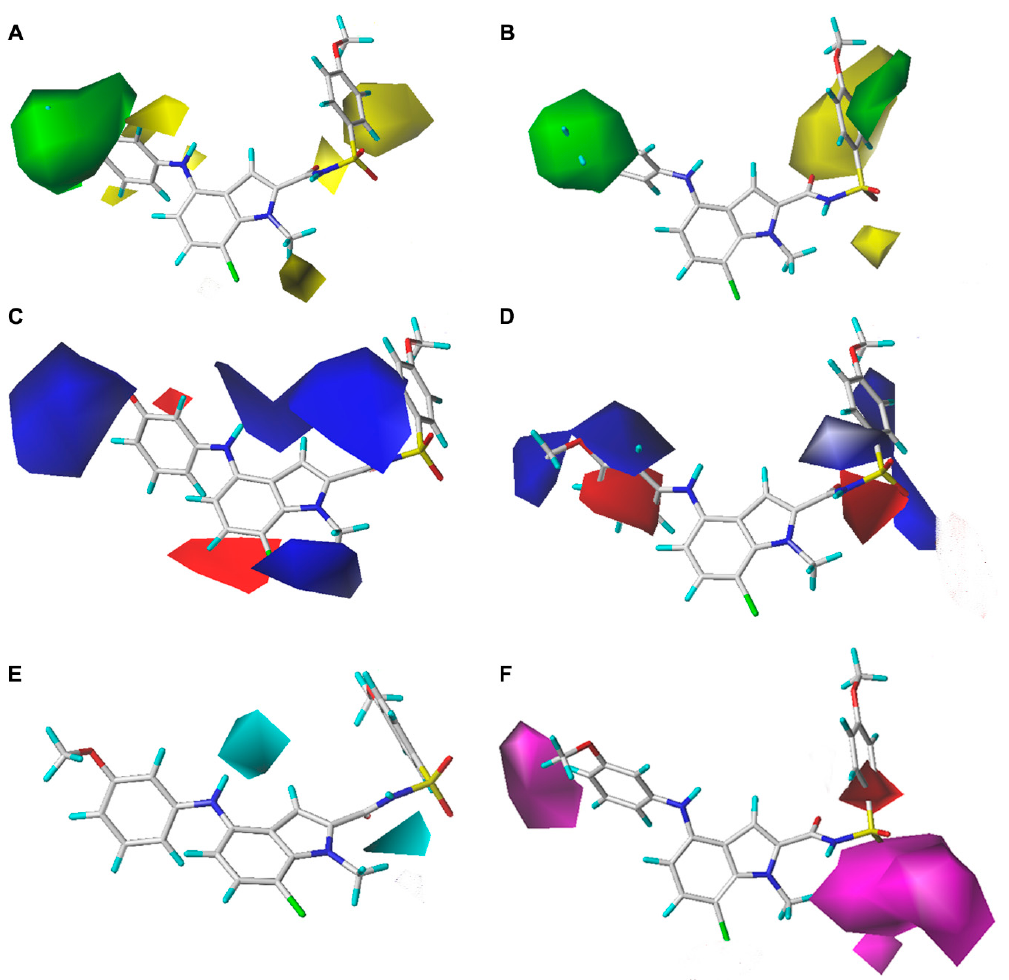
Figure 3. Contour maps of the CoMFA and CoMSIA models using compound 75 as a reference. ( A ) The steric field contour map of the CoMFA model. ( B ) The steric field contour map of the CoMSIA model. ( C ) The electrostatic field contour map of the CoMFA model. ( D ) The electrostatic field contour map of the CoMSIA model. ( E ) The H-bond donor field contour map of the CoMSIA model. ( F ) The H-bond acceptor field contour map of the CoMSIA model. The electrostatic contour maps are shown in Figure 3C,D. The blue areas indicated